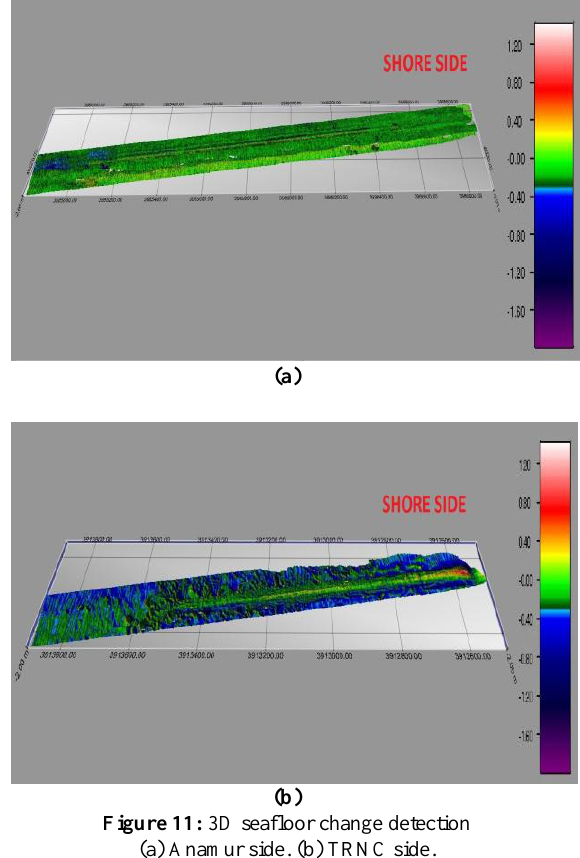
Figure 11: 3D seafloor change detection (a) Anamur side. (b) TRNC